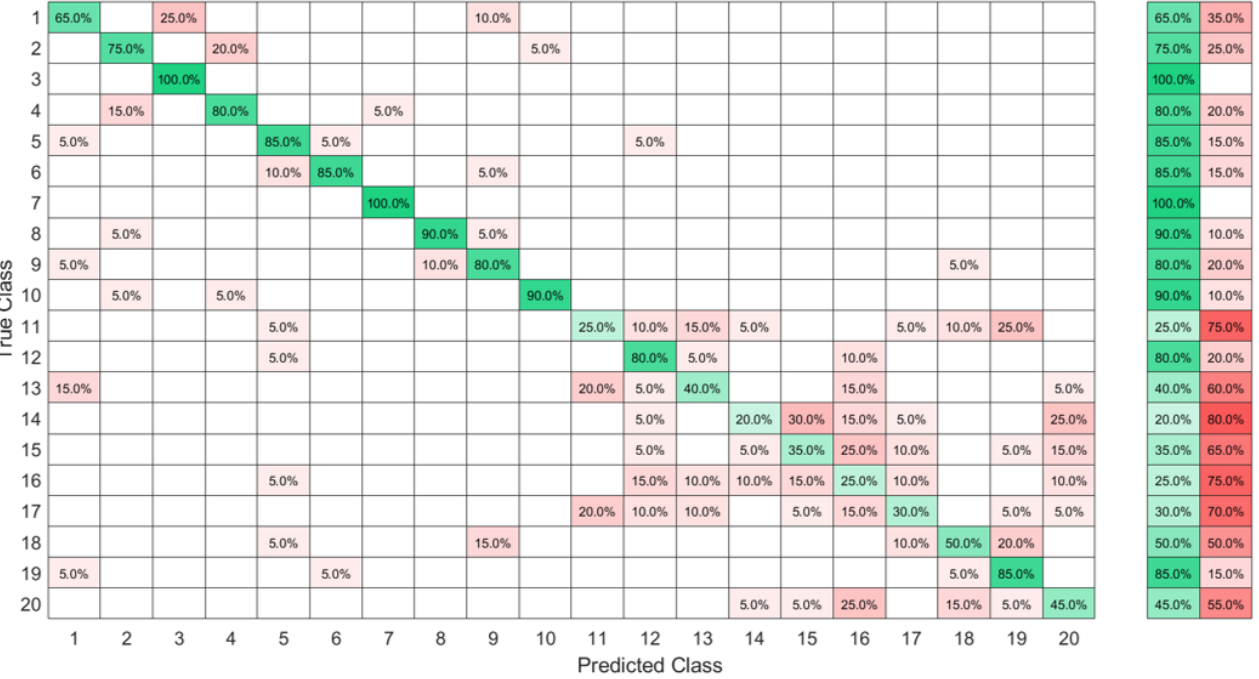
Figure 13. High-ambiguity data set classified by the KTGEL without a previous feature